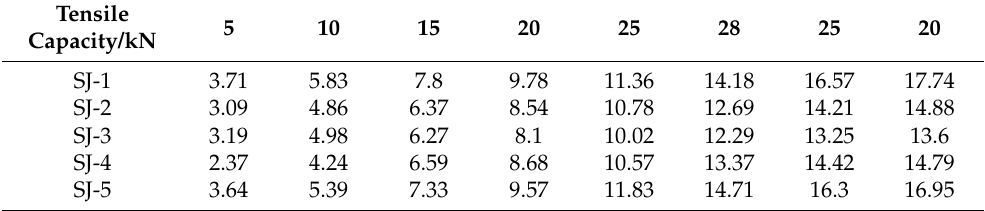
Figure 4. Graphs of the eccentric tensile capacity of sockets on horizontal bars. Table 1. Displacement changes of the horizontal bar socket under tensile force.